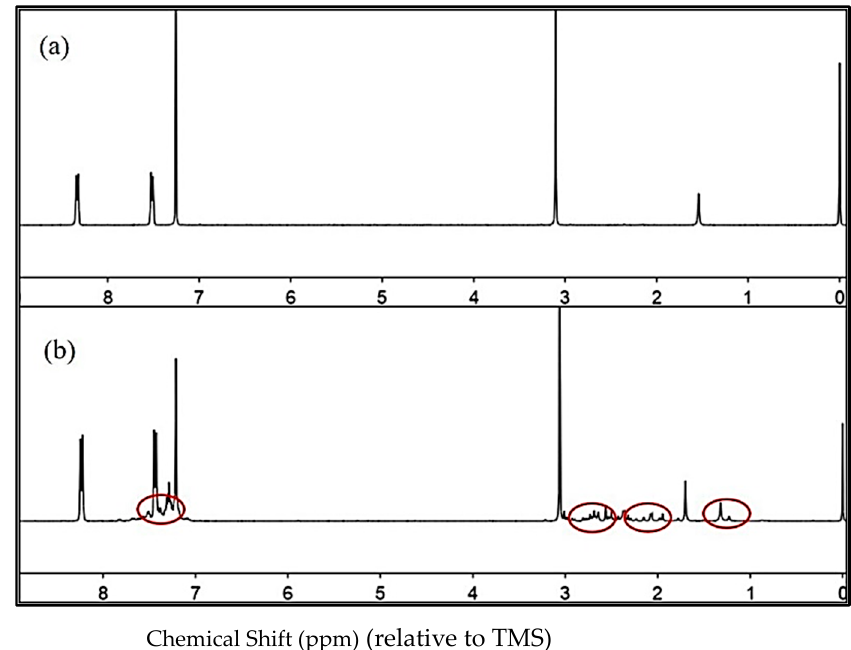
Figure 2. 1 H NMR spectra of ( a ) DMA, ( b ) 1.0 equivalent DMA + C 60 .